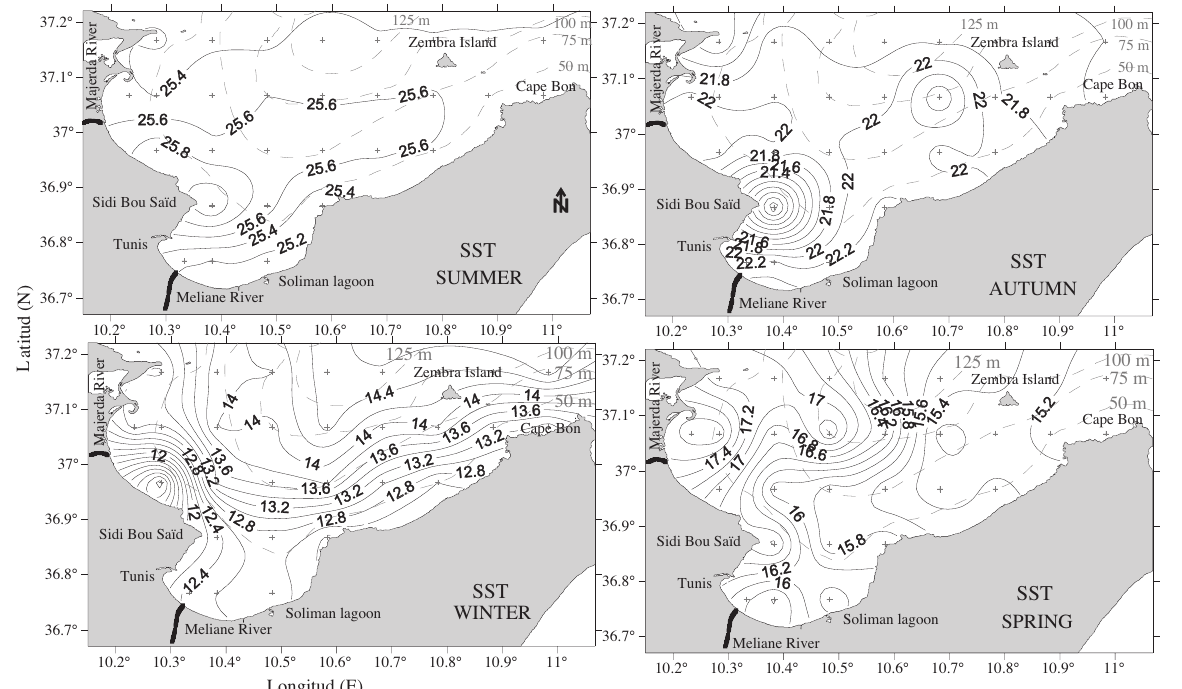
F IG . 2. – Seasonal spatial distribution of sea surface temperature (°C) in the Gulf of